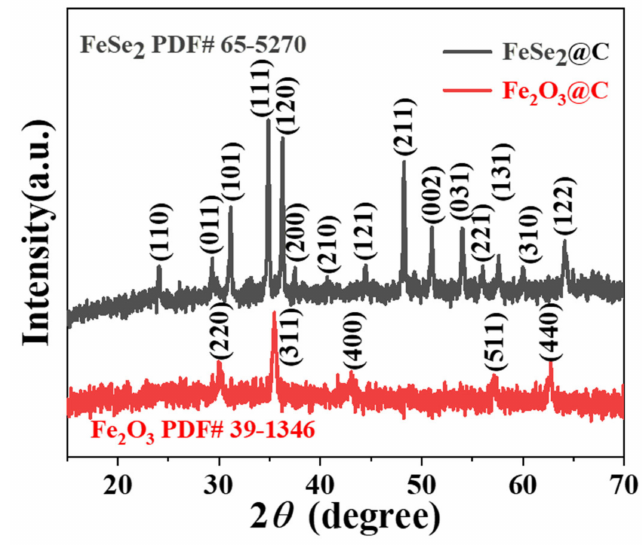
Figure 2. XRD patterns of FeSe 2 @C and Fe 2 O 3 @C composites.